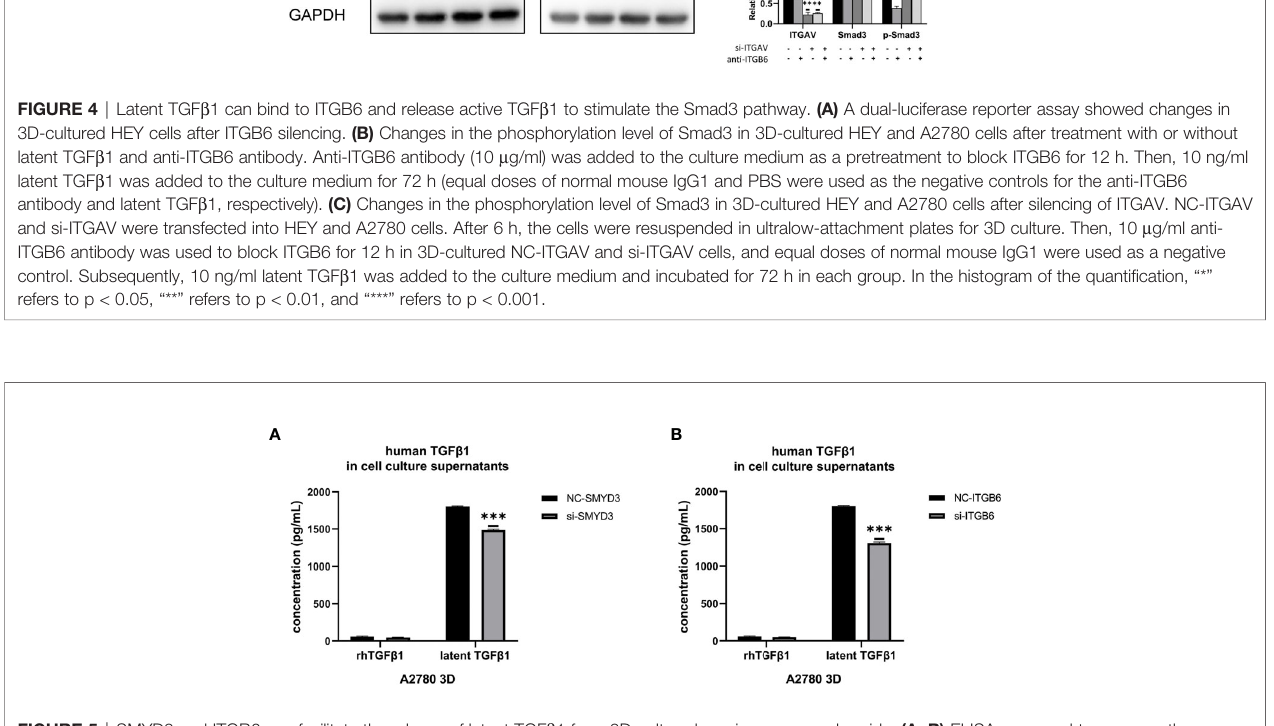
FIGURE 5 | SMYD3 and ITGB6 can facilitate the release of latent TGF b 1 from 3D-cultured ovarian cancer spheroids. (A, B) ELISA was used to measure the concentrations of active TGF b 1 and latent TGF b 1 released from 3D-cultured A2780 cells after SMYD3 (A) or ITGB6 (B) silencing. In the histogram of the ELISA quanti fi cation, “ *** ” refers to p < 0.001.